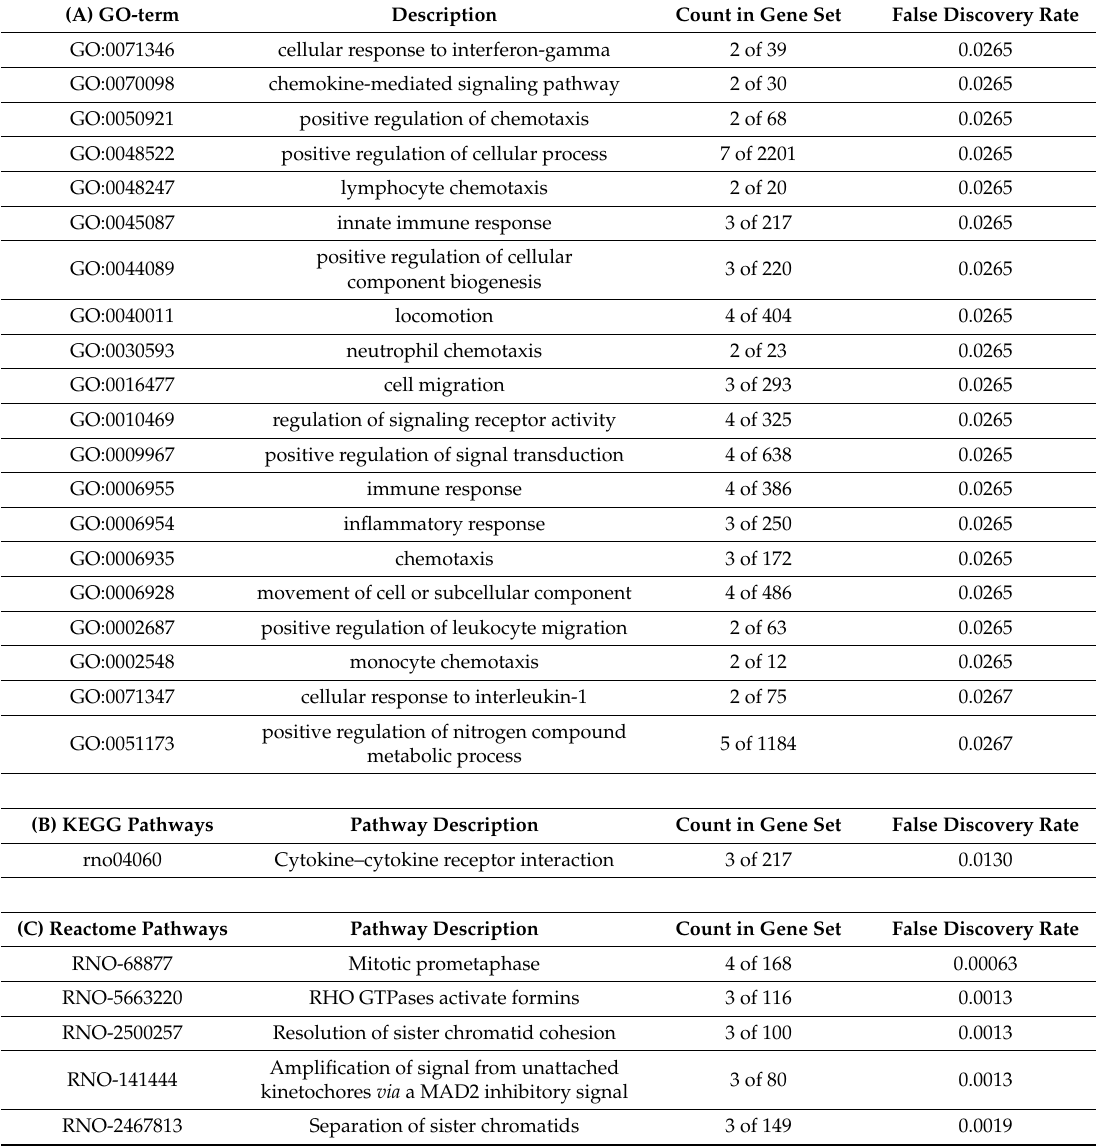
Table 5. ( A ) Gene ontology (GO) biologic process (20 most dysregulated GO-term); ( B ) KEGG pathways and ( C ) reactome pathways of the 18 common dysregulated genes (analyzed by String 11.1